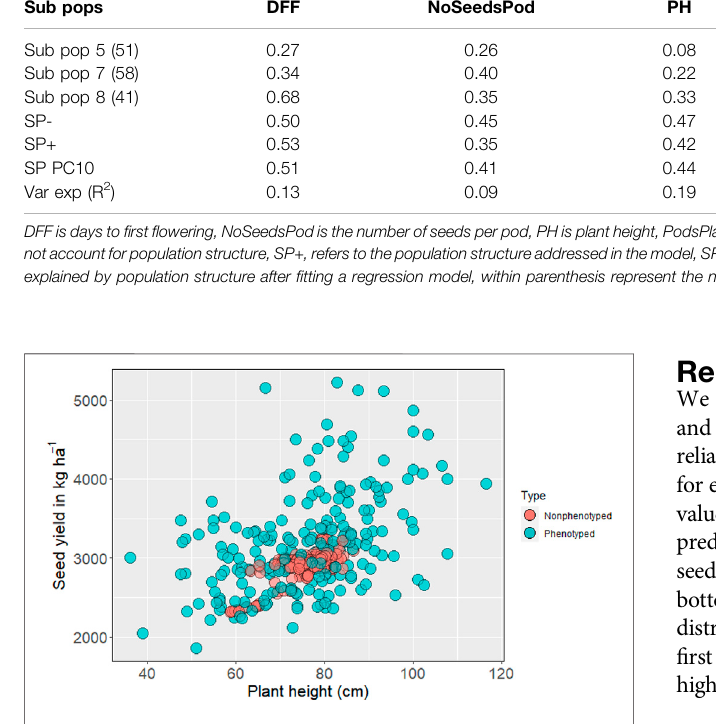
FIGURE 2 | Distribution of phenotyped and predicted nonphenotyped accessionswithintheUSDApeagermplasmcollectionforseedyieldandplant